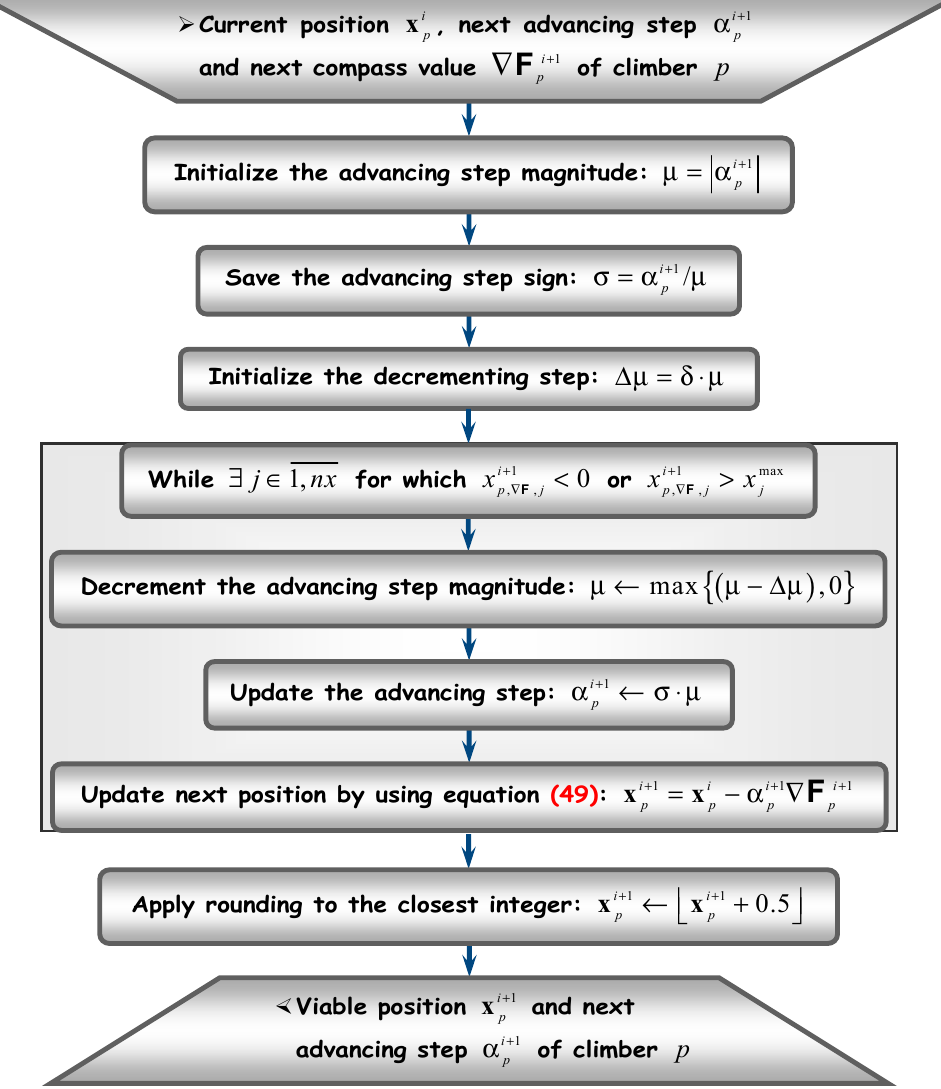
Figure 3. Making a climber position viable.